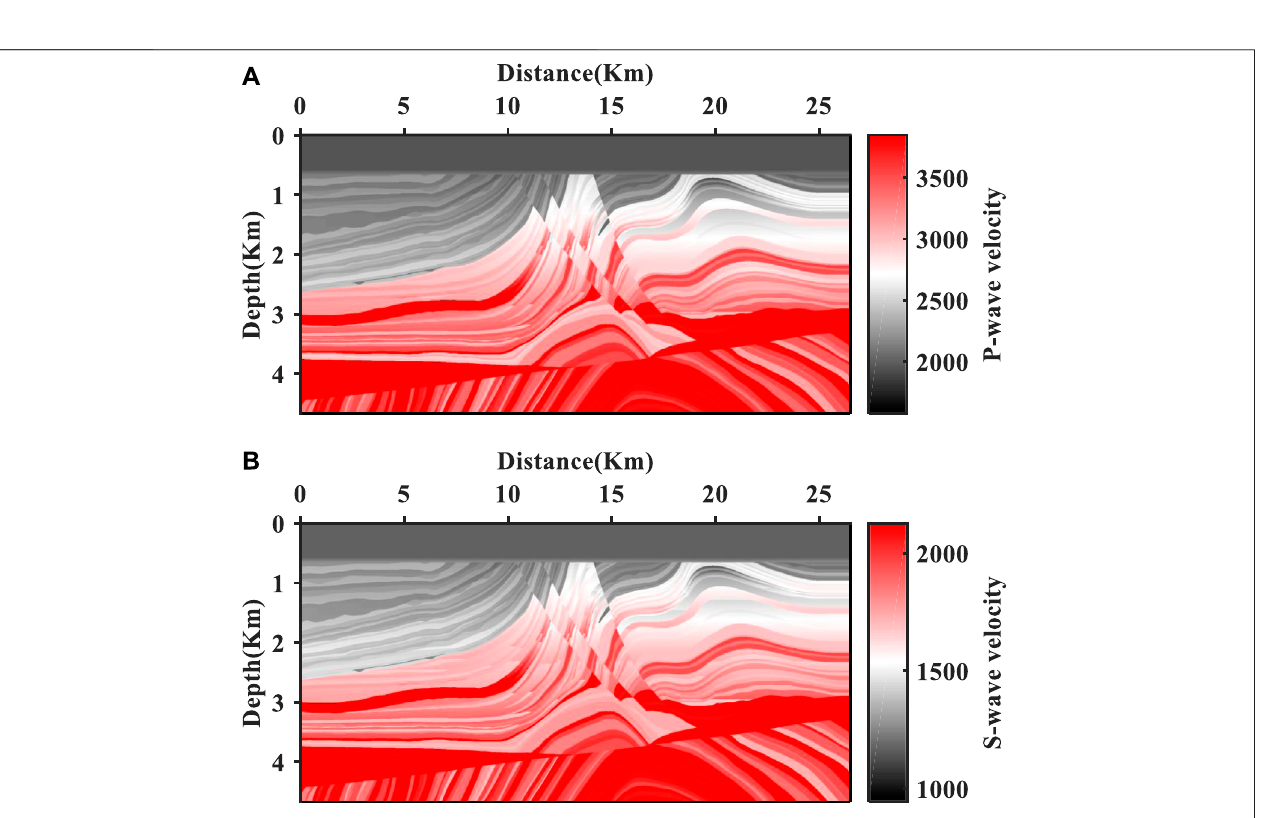
pseudo-Laplace fi lter, has a consistent numerical symbol in amplitude. Therefore, the consistency of the pseudo-Laplace fi lter has been demonstrated by the analysis of amplitude variation versus the opening angle, which indicated that polarity reversal had been corrected.